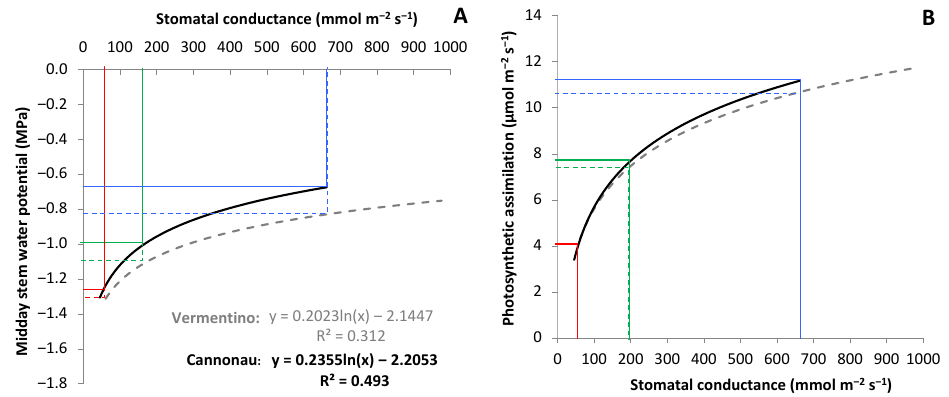
Figure 3. Correlations between ( A ) average stem water potential and stomatal conductance and between ( B ) average photosynthetic assimilation and stomatal conductance at midday in Vermentino (dashed line) and in Cannonau (solid line), in the 3 sites and related ranges for mild (blue lines), moderate (green lines) and severe (red lines) water stress conditions. For Vermentino and Cannonau the mΨs thresholds for target Pn and gs performances are respectively: maximum 11.0, 670, −0.8/11.5, 670, −0.7; medium 7.5, 200, −1.1/7.5, 200, −1.0; minimum 4, 50, −1.25/4, 50, −1.3; luxury water consumption above: −0.7, 12 and 700.